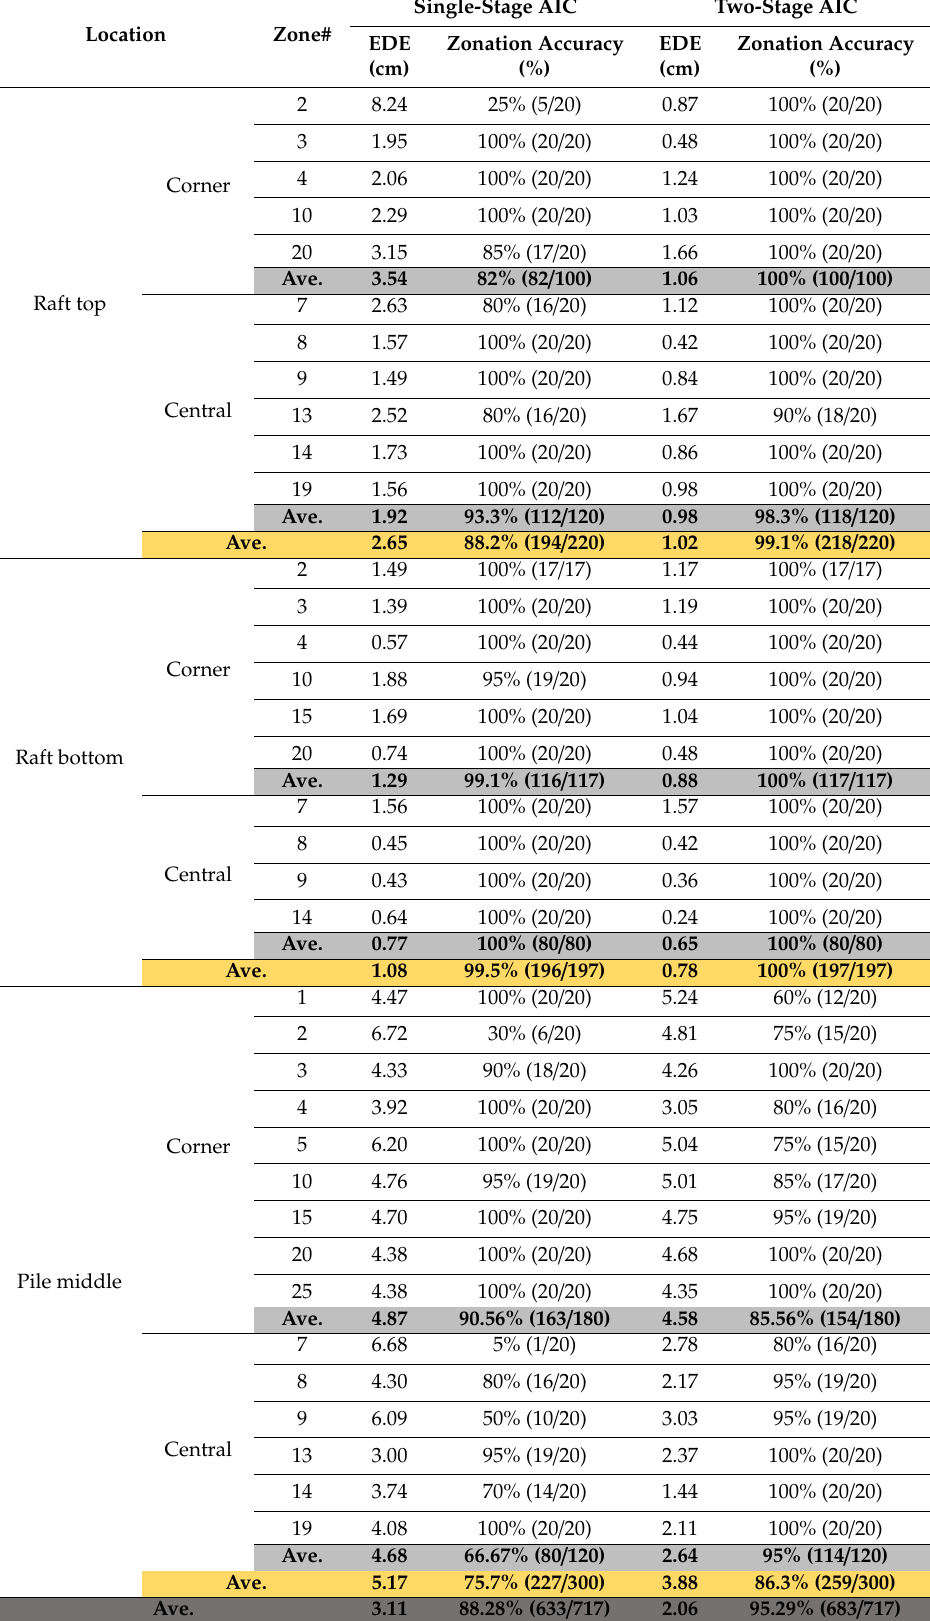
Table 1. The results of source localization estimated by single-stage and two-stage AIC. Location